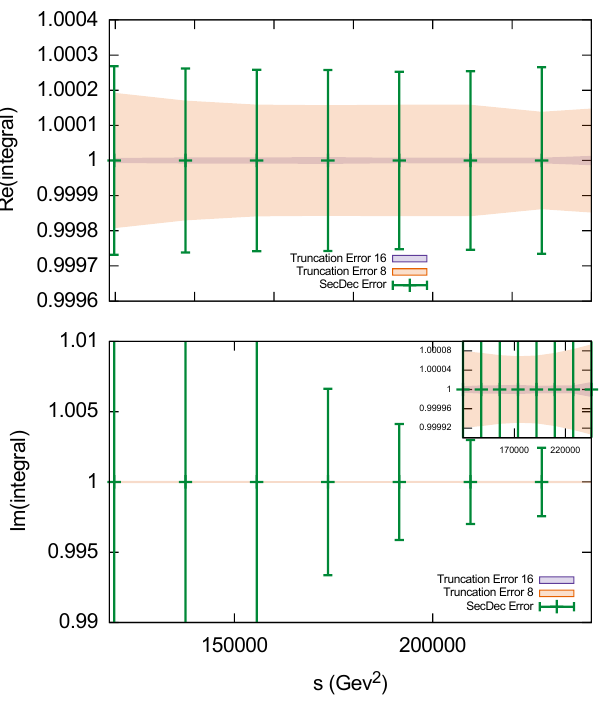
Figure 22 . The relative TayInt uncertainty obtained with 8 and 16 partitions respectively, for the integral I39 at O ( (cid:15) 0 ) above the threshold, with u = (cid:0) 59858 GeV 2 , m 2 = 1 p